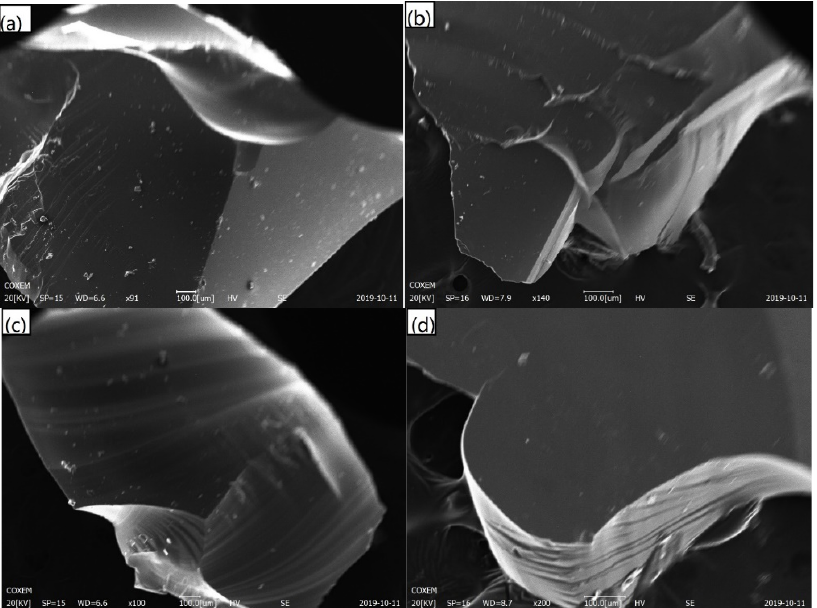
Figure 8. Scanning electron microscope (SEM) image of imitation basalt compound: ( a ) red mud imitation basalt compound; ( b ) fly ash 1 imitation basalt compound; ( c ) fly ash 2 imitation basalt compound; ( d ) coal gangue imitation basalt compound (after high-temperature treatment).